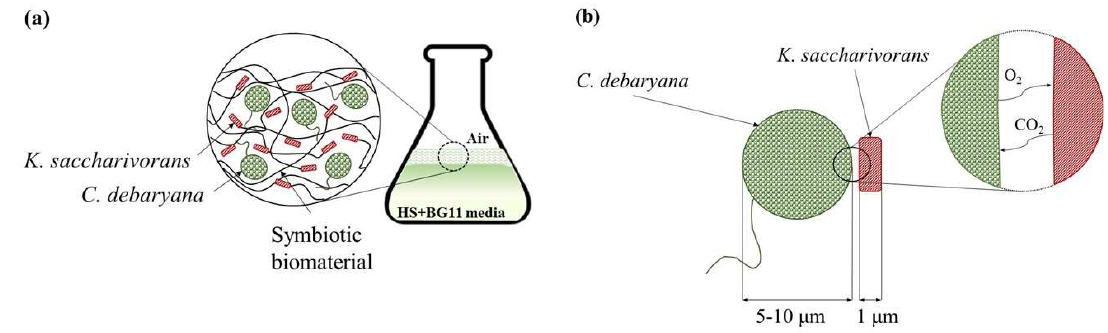
Figure 4. Illustration of ( a ) symbiotic biofilm formation by K. saccharivorans and C. debaryana in HS:BG-11 culture media and ( b ) CO 2 and O 2 transfer between C. debaryana and K. saccharivorans .